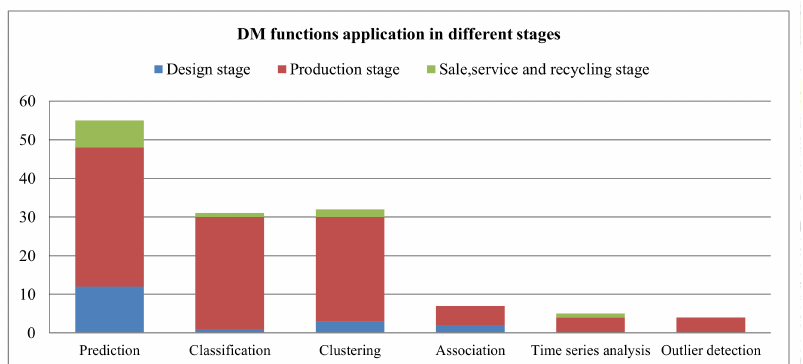
Figure 4. DM function applications in different stages.